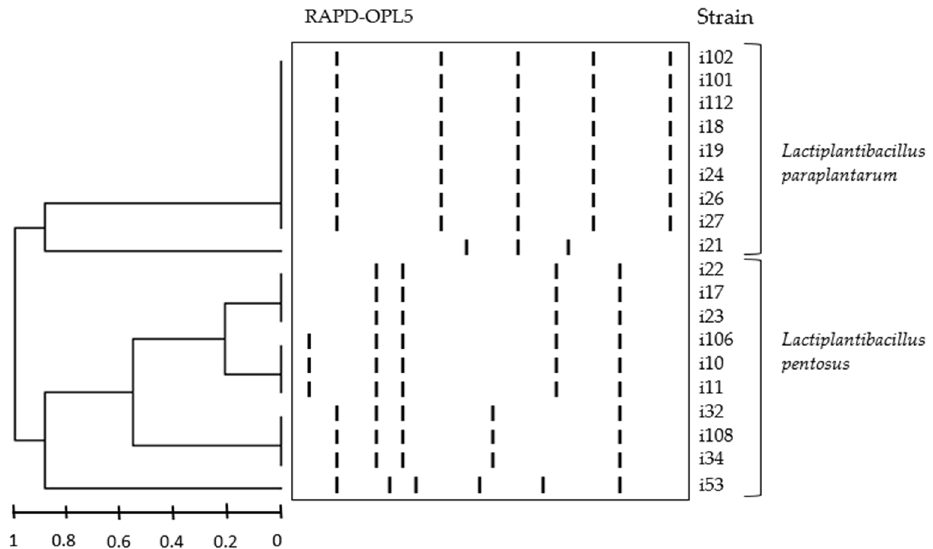
Figure 1. Dendogram generated from cluster analysis of digitalized OPL5 RAPD-PCR fingerprints of 19 LAB strains from Cobrançosa olive fermentations. Fingerprints were grouped by unweighted pair-group algorithm with arithmetic averages (UPGM).